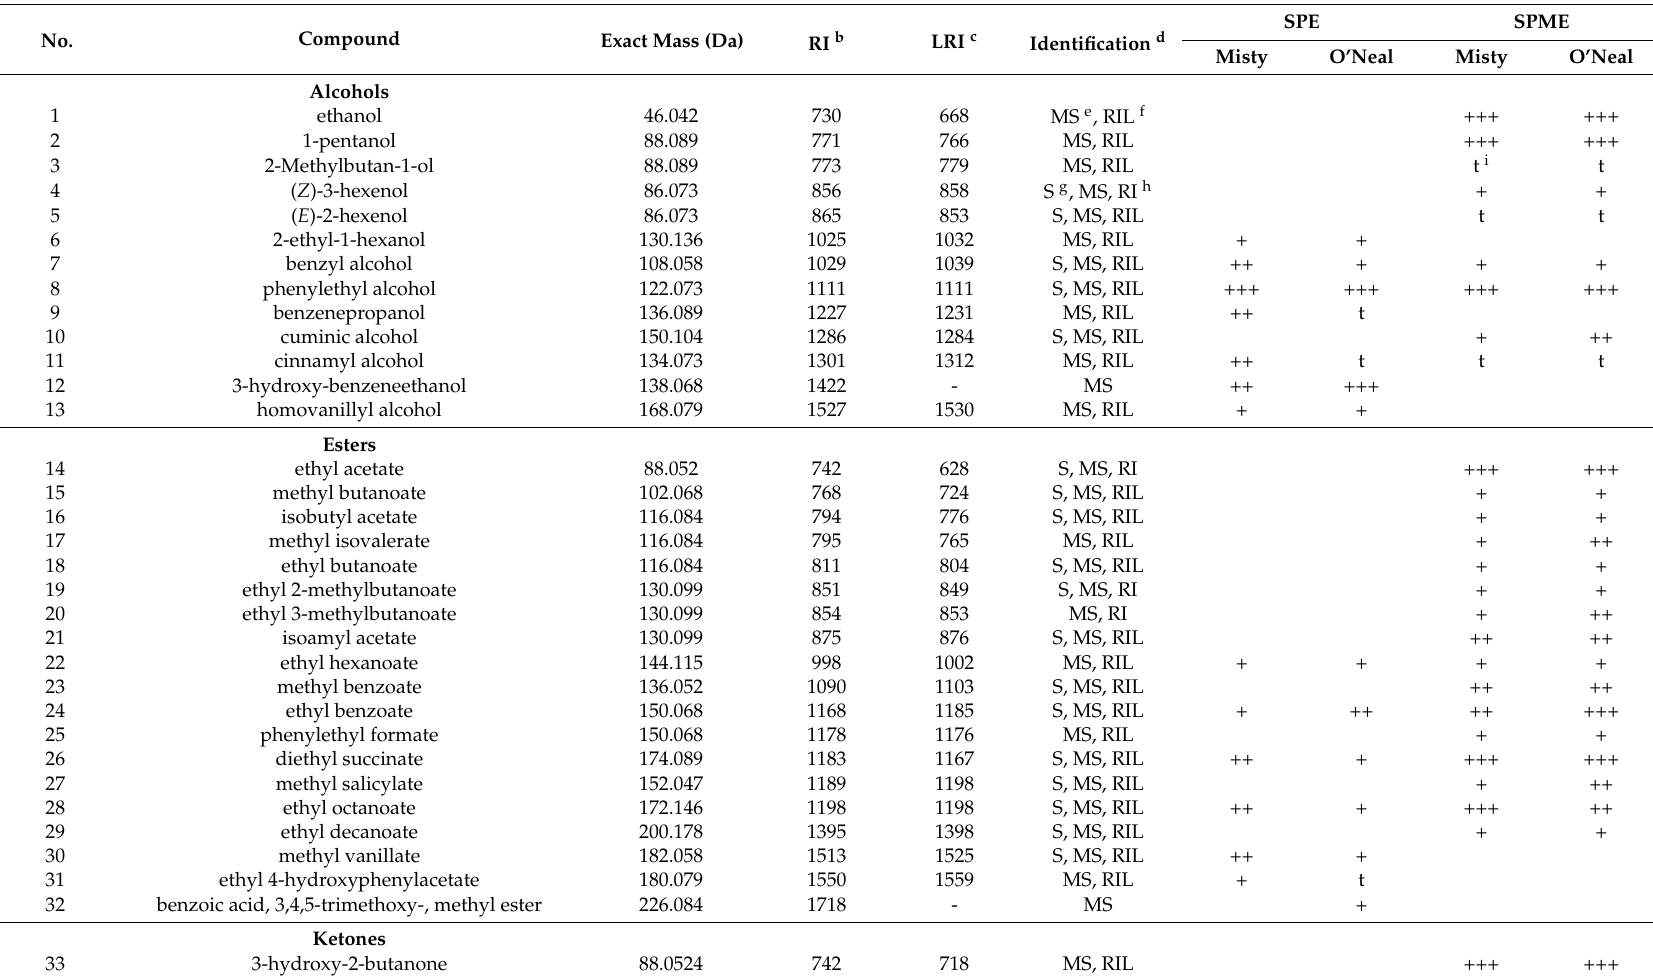
Table 2. Characterization and relative peak size a of the volatile compounds detected in different blueberry wines by different volatile extraction methods.